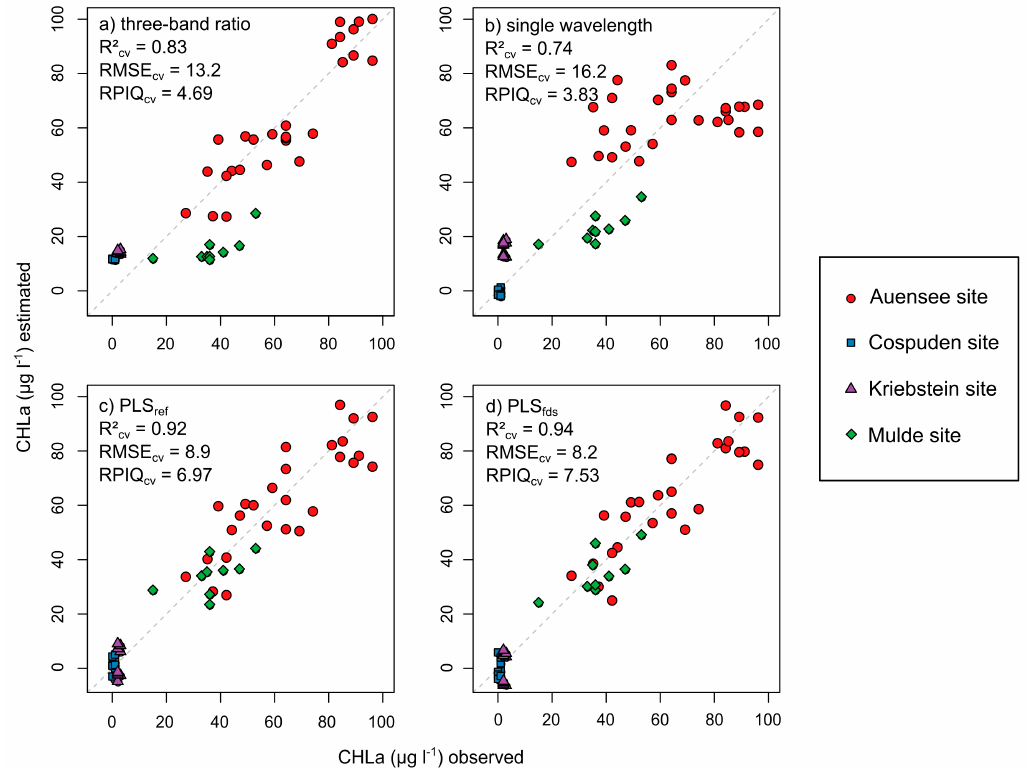
Figure 9. Measured and cross-validated prediction values of CHLa with error metrics based on the entire dataset: ( a ) three-band ratio, ( b ) single wavelength at 690 nm of first derivative, ( c ) partial least squares (PLS) ref = PLS regression based on reflectance spectra, and ( d ) PLS fds = PLS regression based on first derivative spectra. The dashed line represents the 1:1 line.